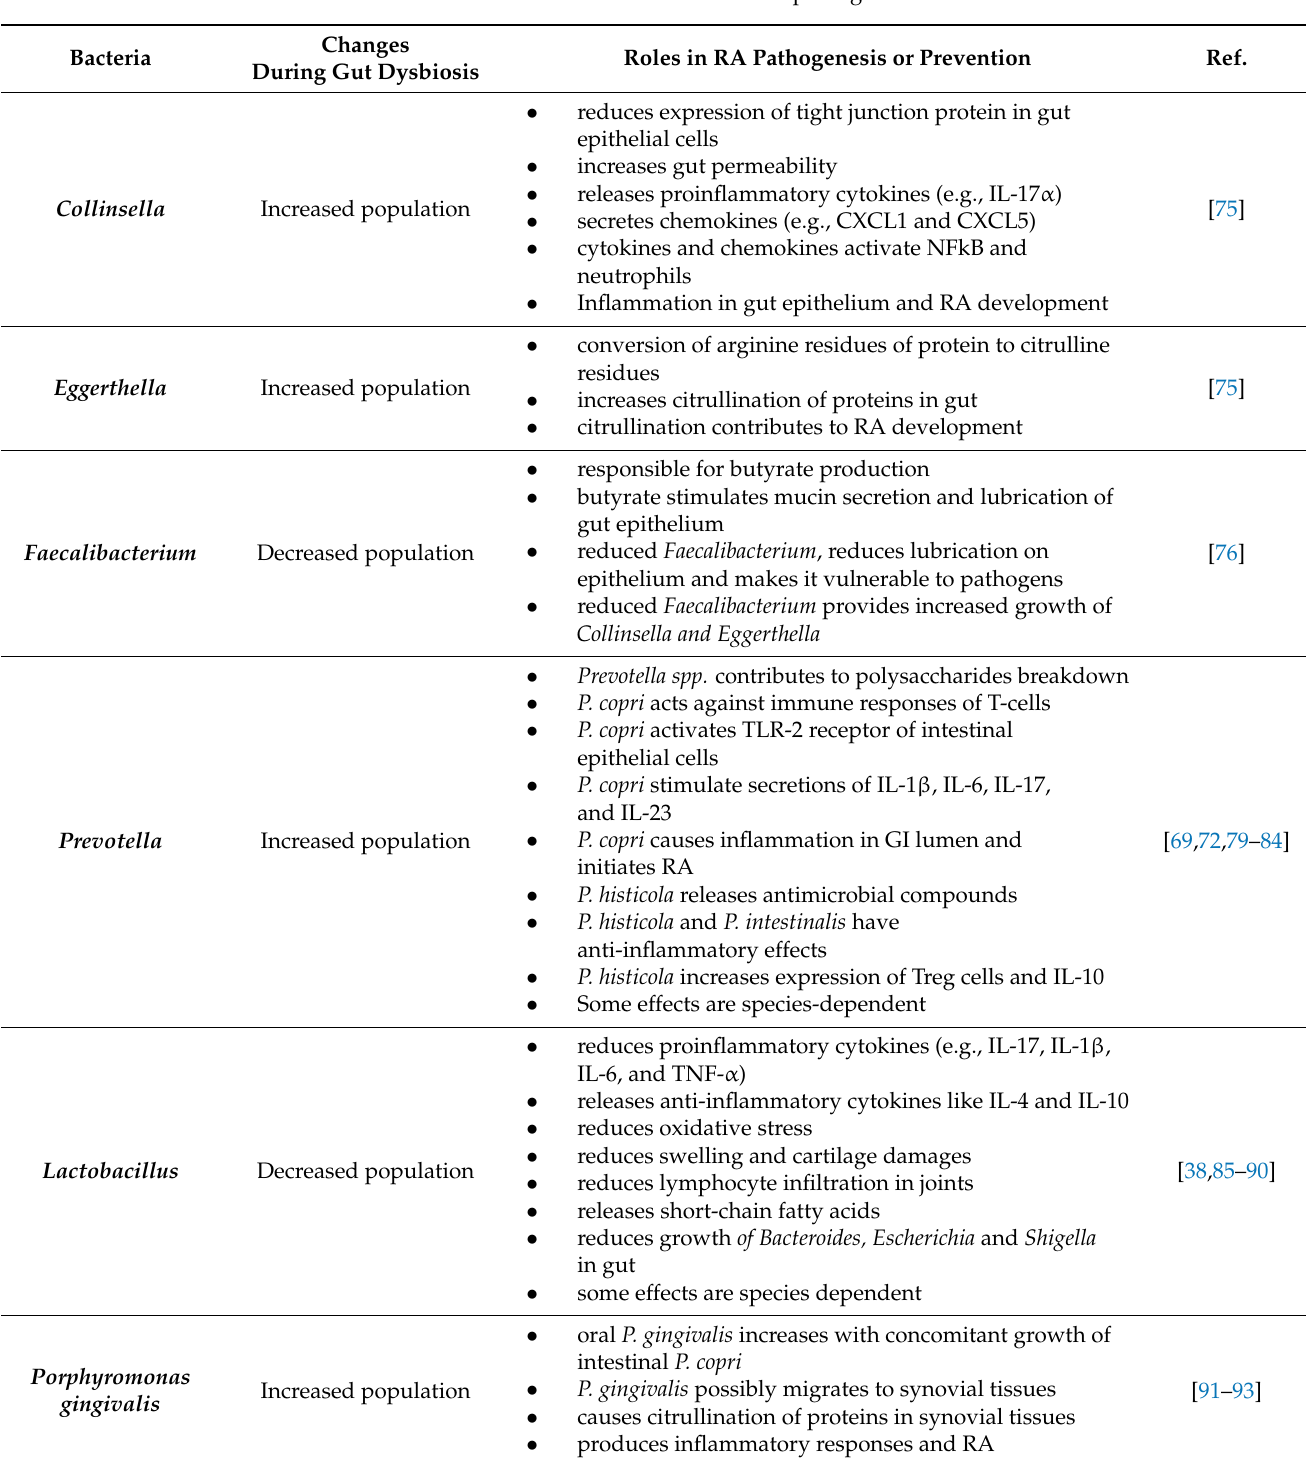
Table 1. The roles of some bacteria in RA